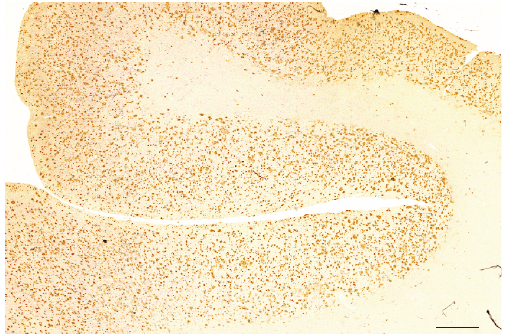
Figure 1: Extensive β -amyloid (A β ) deposition in gyri of the temporal lobe in a case of Alzheimer’s disease (AD) (A β immuno- histochemistry, bar = 1mm).